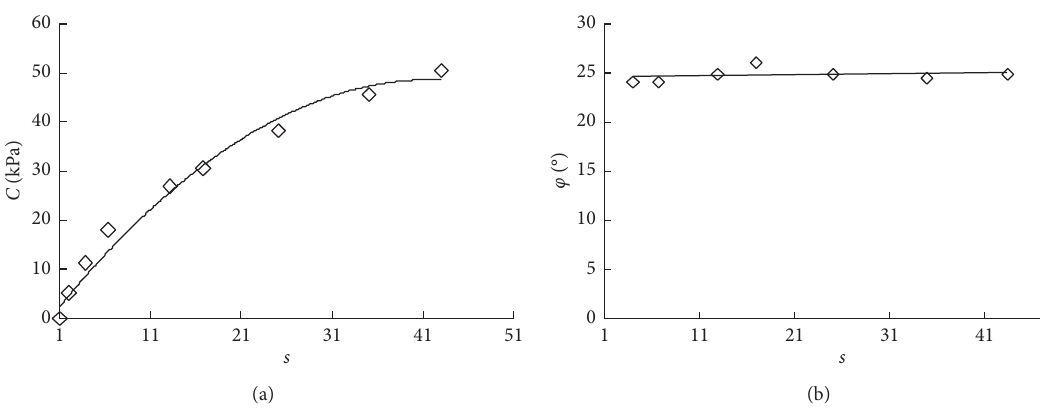
Figure 17: Relationship between structure parameter and cohesion. (a) Variation of cohesion with generalized sensitivity; (b) Variation of internal friction angle with generalized sensitivity.